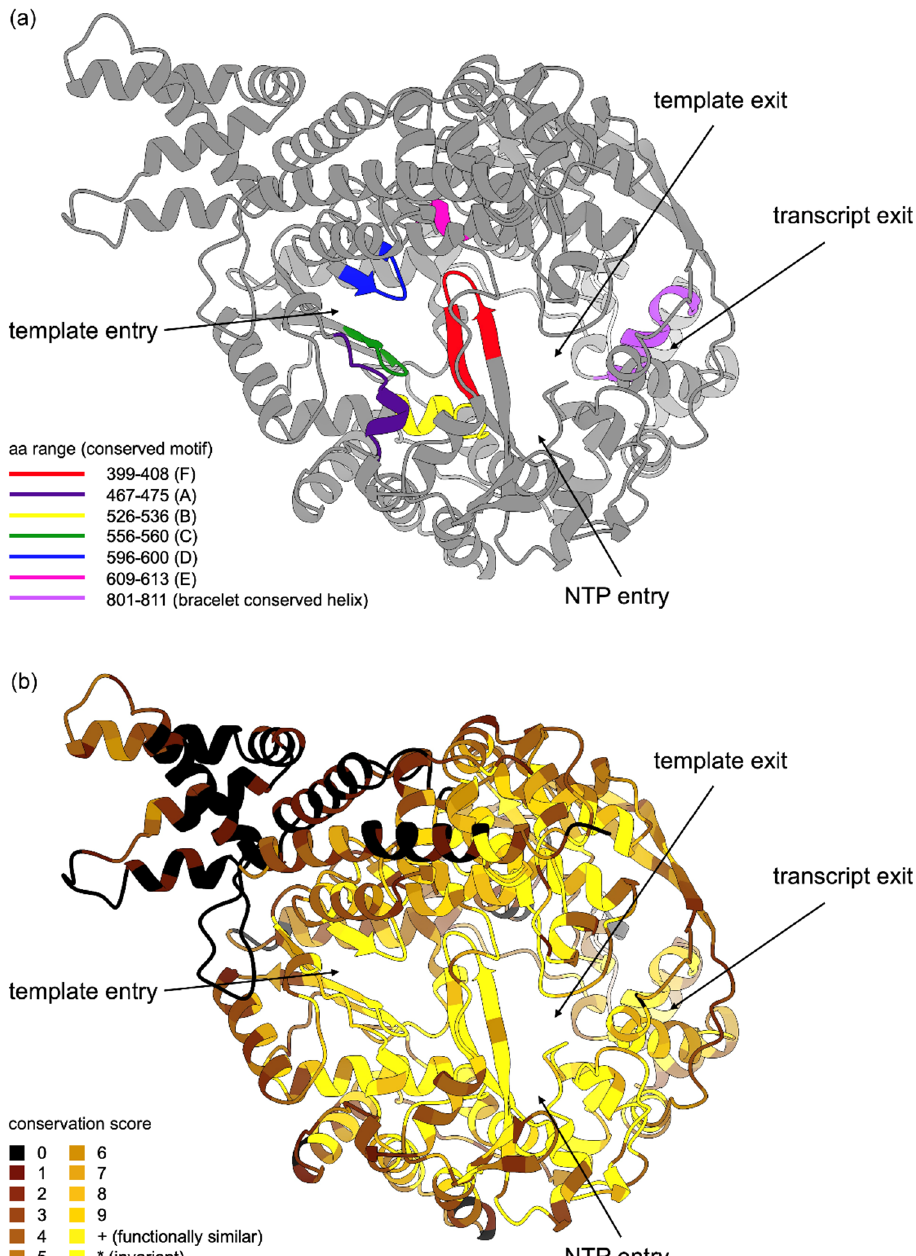
Figure 6. Predicted three-dimensional structure of RDRP protein in LRV1 demonstrating functional motifs and conservation. ( a ) Position of functional regions (residue numbering is for LRV1- LgyM4147). Unannotated parts of the molecule are in grey. ( b ) Conservation of amino acid residues in the alignment (Figure S4). Conservation scores are calculated in Jalview. Distant parts of the molecule are shown with lighter shades of colors.